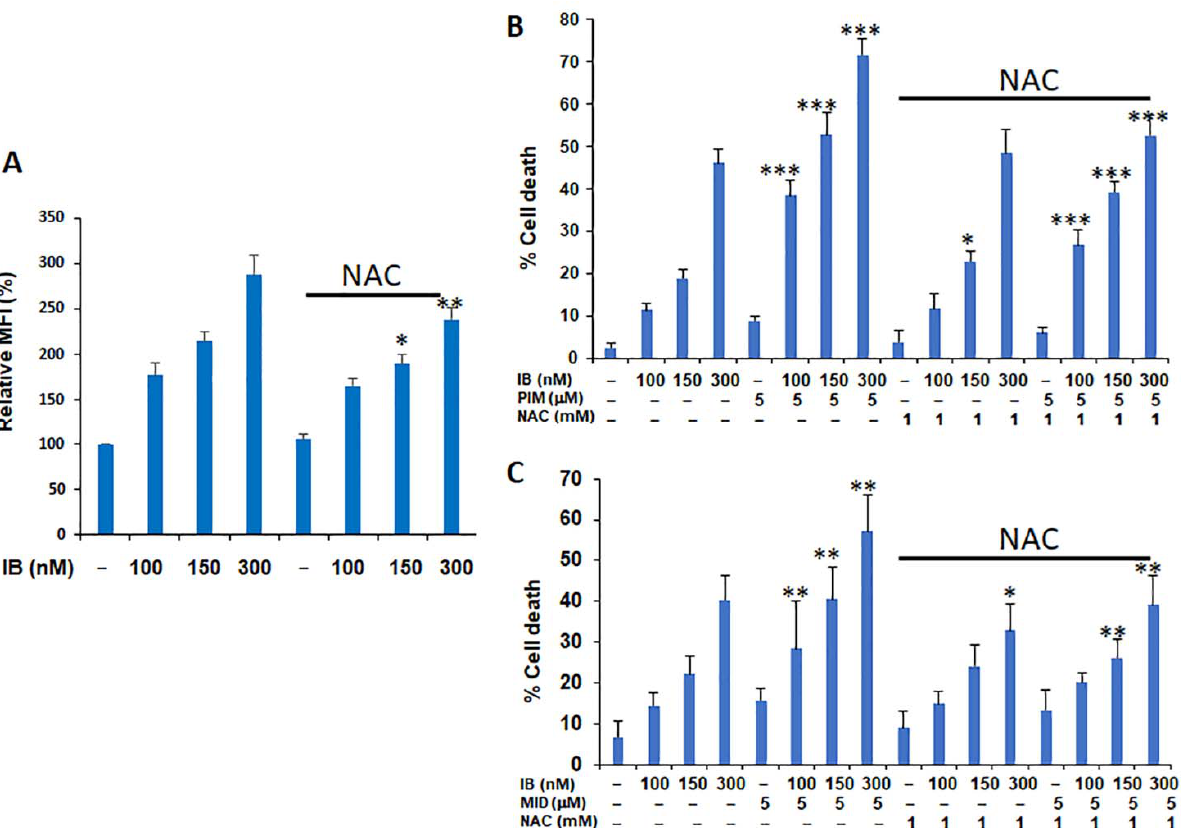
Figure 9. N-acetylcysteine effectively reverses IB-mediated cell death alone or in combination with pimozide or mibefradil. ( A ) MitoSox levels were assessed following IB treatment and potential reversibility was determined with NAC treatment (1 mM) for 4 h. Comparison of IB + PIM (Panel ( B ); n = 5) and IB + Mib (Panel ( C ); n = 6) on MV4-11 cells for 48 h was performed. Treatment of N-acetylcysteine (NAC) was also performed to test for reversal of cytotoxicity. Comparisons on the left were comparing IB vs. Pim or IB vs. Mib; p values on the right under the NAC heading compared +/- NAC for the same combination doses of IB/Pim or IB/Mib. * p < 0.05; ** p < 0.01; *** p < 0.001.